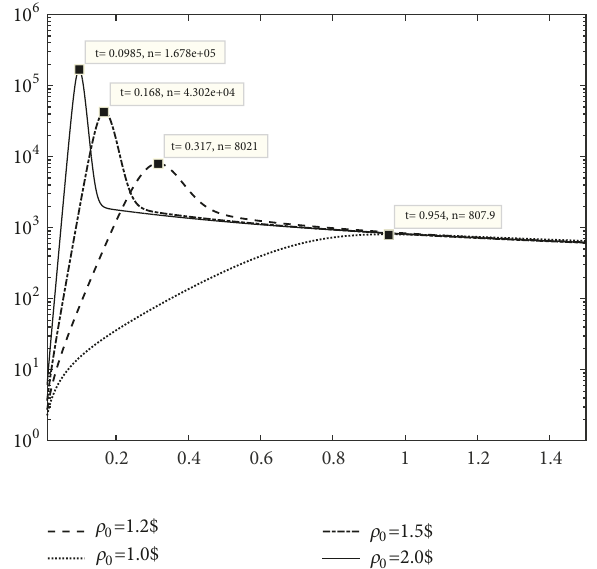
Figure 3: Peak and time to the peak of the flux for step feedback with 𝜌 = 1$, 1.2$, 1.5$, and 𝜌 = 2$.